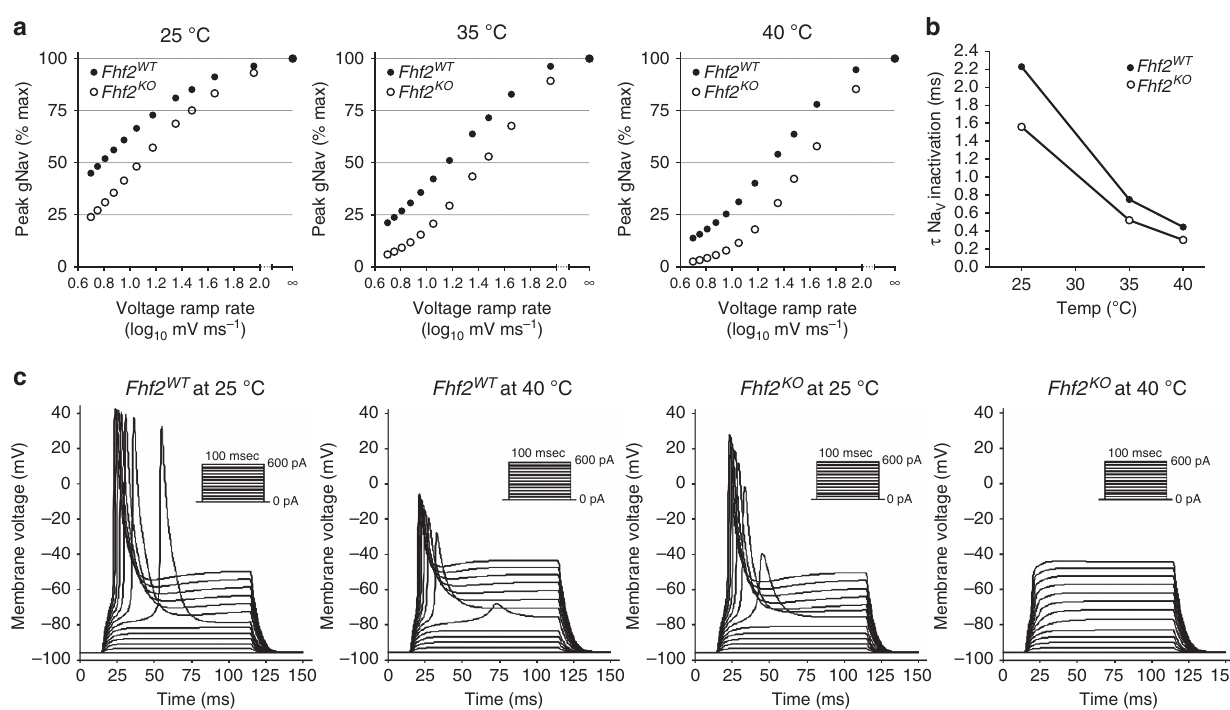
Figure 4 | Computational models of Fhf2 WT and Fhf2 KO cardiomyocytes. The two models have the same gNa V –peak in response to instantaneous depolarization steps (Supplementary Fig. 4) and the same Na V temperature-dependent kinetic scaling factor (Q10 ¼ 3, see Methods), and differ only in their Na V inactivation parameters. ( a ) Voltage ramp Na V inactivation in cardiomyocyte models. Simulations were conducted at 25, 35 and 40 (cid:2) C. Na V sensitivity to closed-state inactivation during slower voltage ramp is potentiated in the Fhf2 KO model at all temperatures, closely resembling Na V 1.5 recordings ± FHF2VY (Fig. 3f). ( b ) Na V open-state inactivation rate. t for decay of sodium current in response to voltage step to (cid:2) 20mV are plotted for both models cells at 25, 35 and 40 (cid:2) C. Open-state inactivation is accelerated in the Fhf2 KO model at all temperatures. ( c ) Model cardiomyocyte excitability. 100ms current injections ranging from 0 to 600pA (insets) were applied to Fhf2 WT and Fhf2 KO models at 25 and 40 (cid:2) C. Both models are excitable at 25 (cid:2) C, but only the Fhf2 WT model is excitable at 40 (cid:2) C, comparable to cardiomyocyte recordings (Fig. 3a).